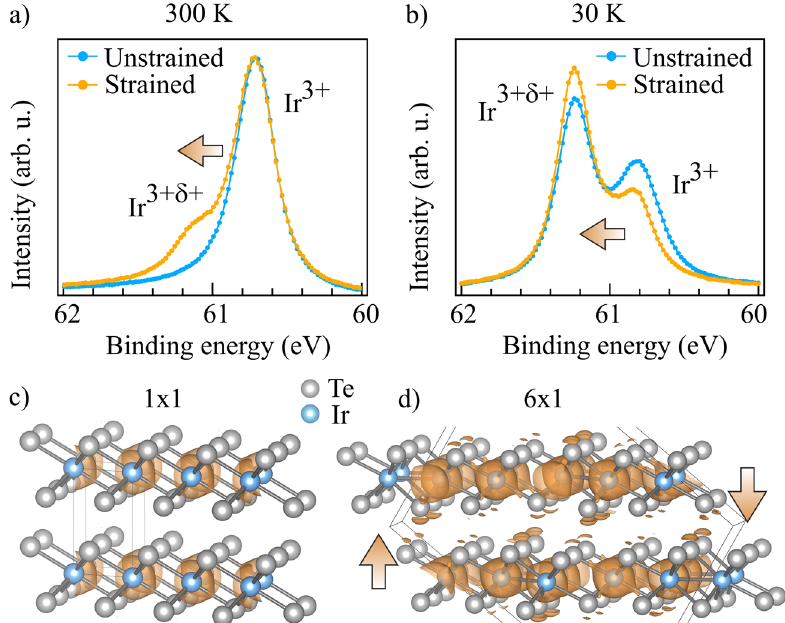
Fig. 3 Strain-induced charge transfer. a XPS measurements ( h ν = 130 eV, T = 300 K) of the Ir 4f 7/2 core level for strained and unstrained samples, measured at the same position as the relevant ARPES data. The appearance of a distinct shoulder in the strained sample reveals the appearance of the Ir 3 + δ + site, not normally present above 280 K, implying Ir to Te charge transfer. b The same Ir 4f 7/2 core level at 30 K. Again, the Ir 3 + δ + peak is enhanced in the strained case. The ratio of the Ir 3 + δ + peak area to the total weight, Ir 3 + δ + /(Ir 3 + + Ir 3 + δ + ), is 0.67 in the 6 × 1 phase, as expected for four out of six atoms being dimerized, implying a pure 6 × 1 phase in the presence of strain. c Calculated electronic density (orange isosurface) in the high-temperature 1 × 1 phase. d Electronic density in the 6 × 1 plotted at the same isosurface level as for the 1 × 1 phase in ( a ), revealing an increase of charge density in the interlayer region (highlighted by arrows) that is maximized in the strain-stabilized 6 × 1 phase. Both calculations are obtained from the sum of electronic states between E F – 7 eV and E F